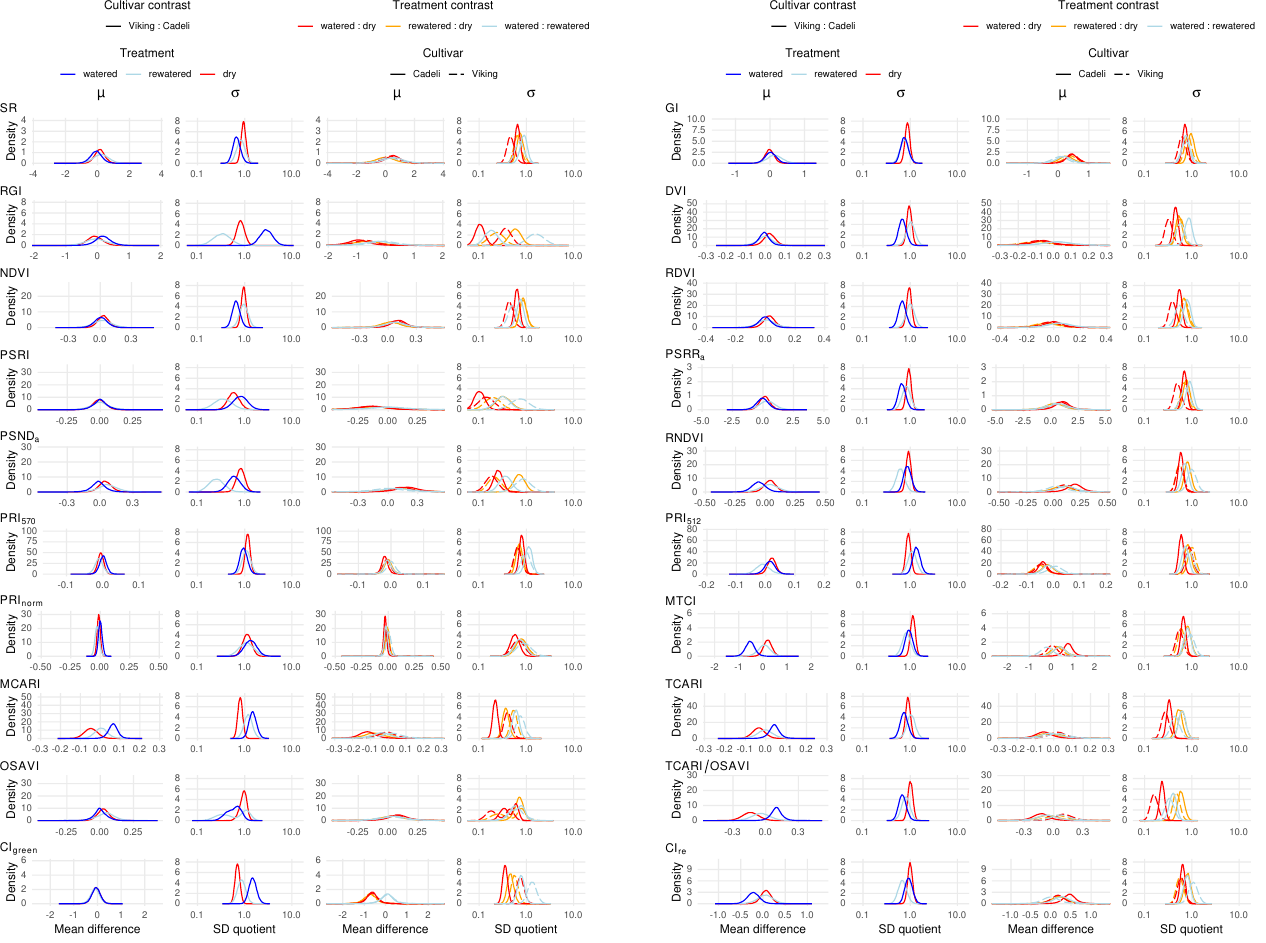
Figure 6. Posterior distributions of the mean ( µ ) and standard deviation ( σ ) differences between experimental factors for each vegetation index. The mean and standard deviation differences are assumed to be additive and multiplicative, respectively. The left-hand and right-hand side subplot columns depict comparisons between the cultivars and watering regimes, respectively. The latter are on a semi-logarithmic